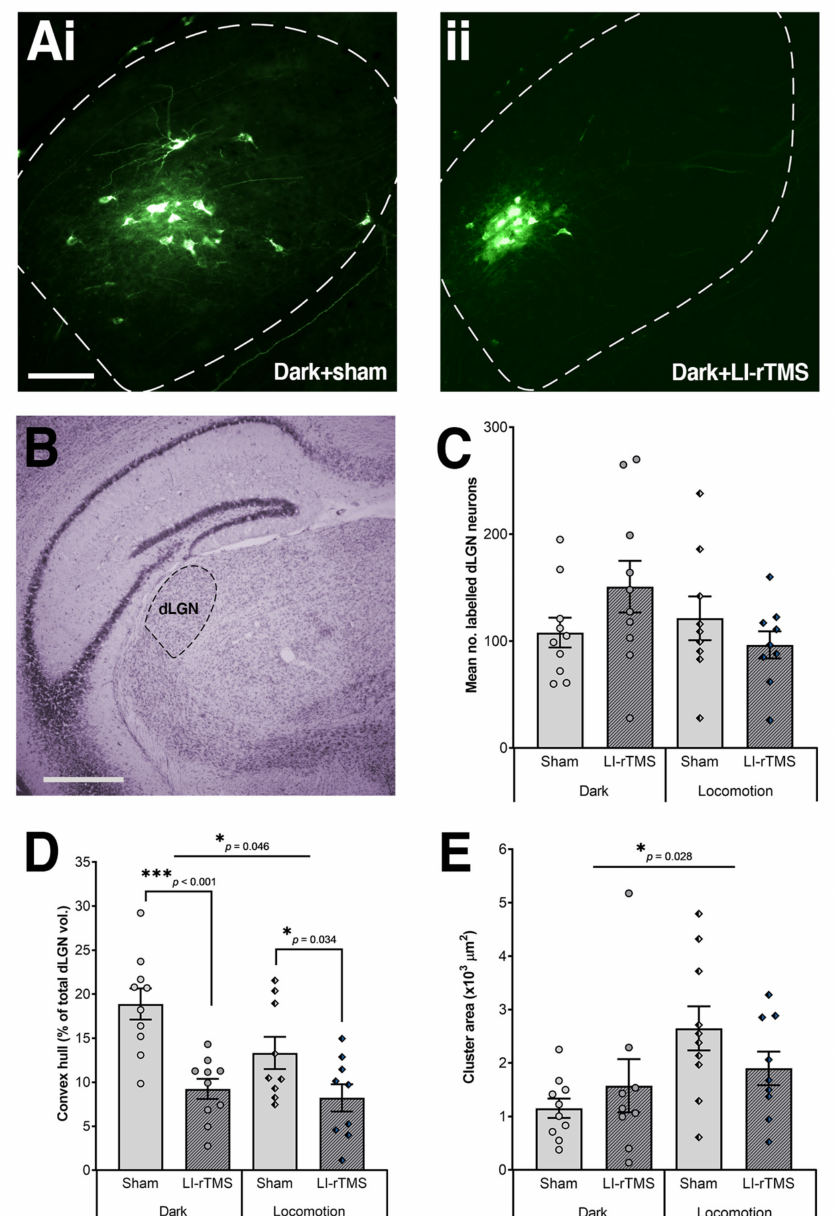
Figure 2. Geniculocortical neuron labelling of adult ephrin-A2A5 -/- mice following chronic LI-rTMS in a dark environment. Injections of fluorescent dye into V1 retrogradely labelled dLGN neurons. ( Ai ) Example image of disperse labelling in dark-sham-treated ephrin-A2A5 -/- mice, whereas ( Aii ) dark-LI-rTMS-treated mice exhibited less dispersion (scale bar = 100 µ m). ( B ) Example image of dLGN identified in a cresyl-stained section (scale bar = 250 µ m). ( C ) The average number of labelled dLGN neurons were not different between treatment (sham vs. LI-rTMS) and environment (dark vs. locomotion) groups. ( D ) The total dispersion volume of dLGN neurons was reduced by chronic online LI-rTMS. Interestingly, locomotion groups also had less overall dispersion volume as compared to subjects in the dark group. ( E ) Main cluster areas were not altered by LI-rTMS. However, locomotion groups had larger areas as compared to dark animals. Error bars represent SEM. Uppermost lines denote univariate analysis (* p < 0.05) and angled lines denote follow-up pairwise comparisons with Sidak correction (* p < 0.05, *** p <